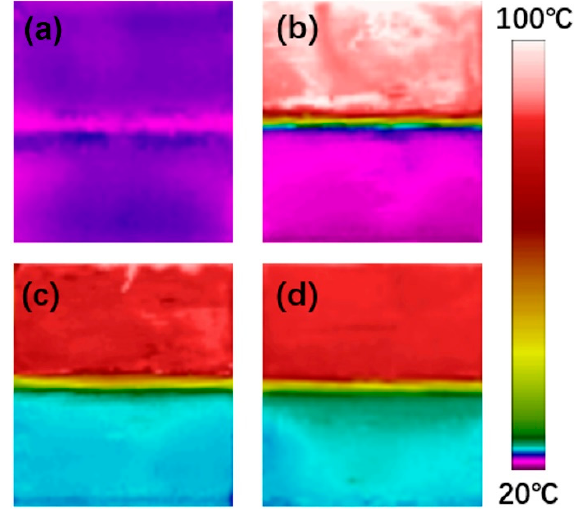
Figure 8. Temperature distributions before heating ( a ), using commercial polyurethane PU without phase change properties, SPU ( b ) and the rGOF/SPU composite as TIMs before ( c ) and after ( d ) heating.